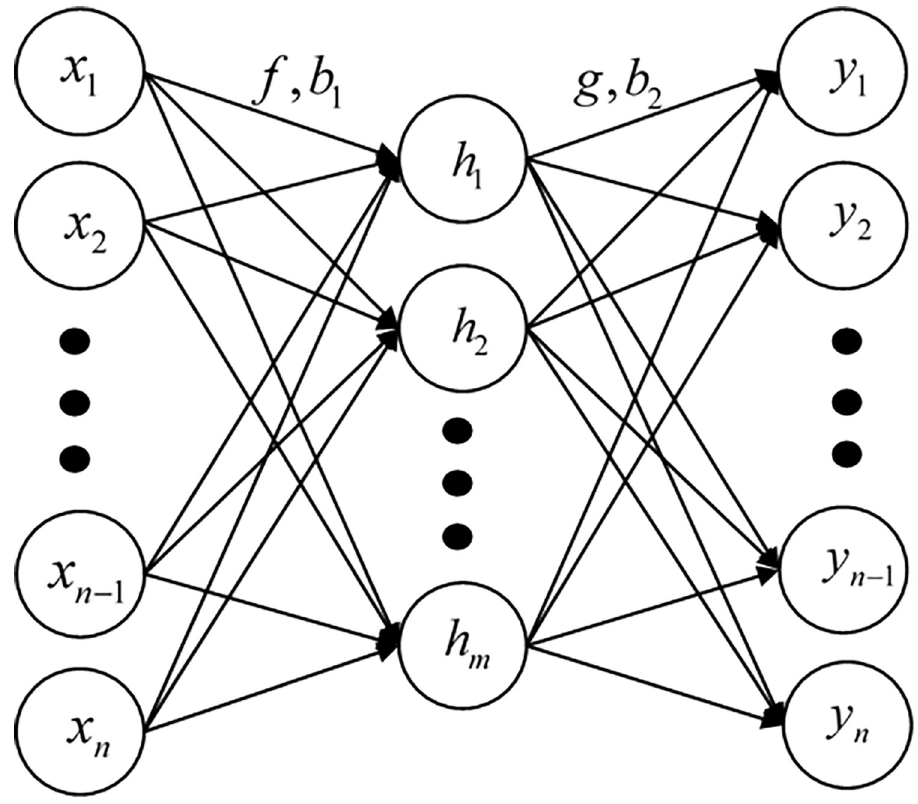
Fig 3. Three-layer AE